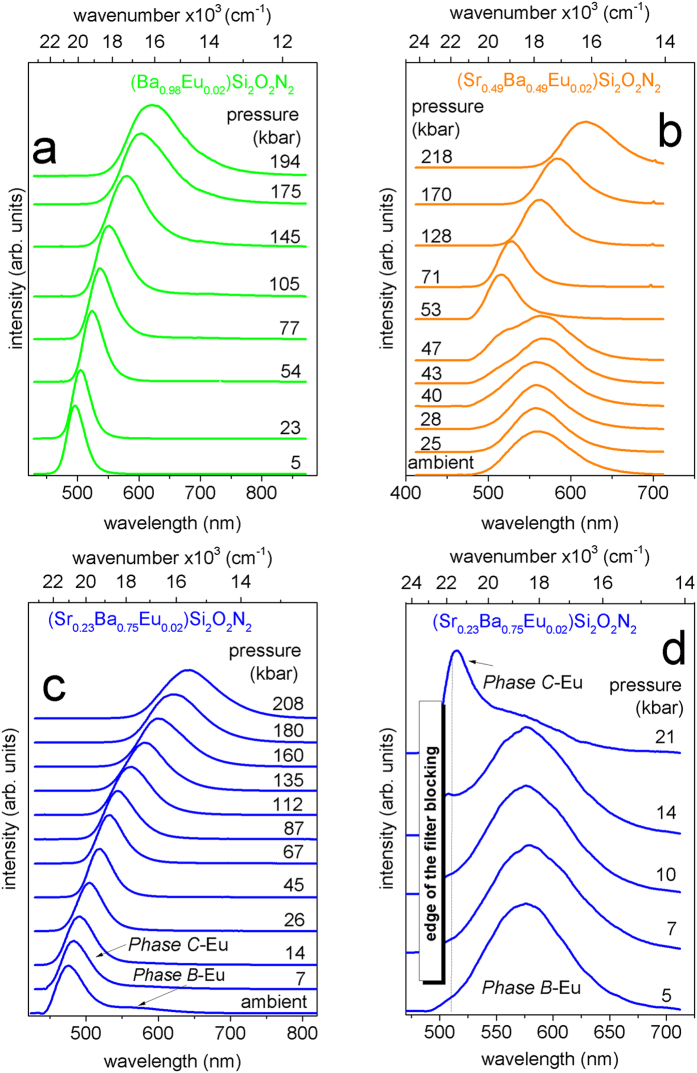
PL spectra of (Sr0.98-xBaxEu0.02)Si2O2N2 under different pressures (a) x = 0.98 excited at 442 nm (d), x = 0.49 excited at 442 nm, (c,d) x = 0.75 excited at 442 nm and 488 nm, respectively.